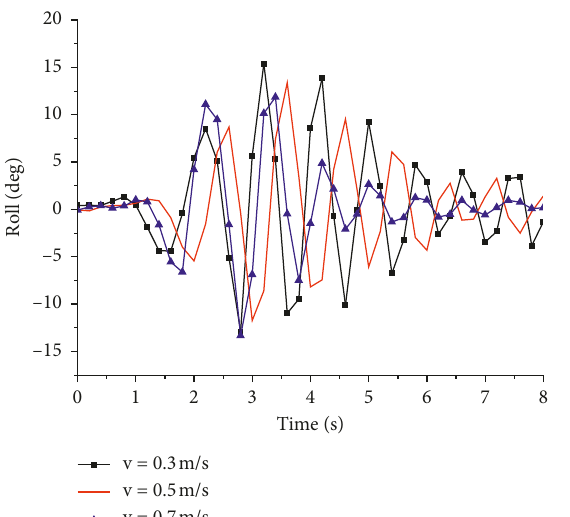
Figure 13: Roll time-history curve with different landslides.